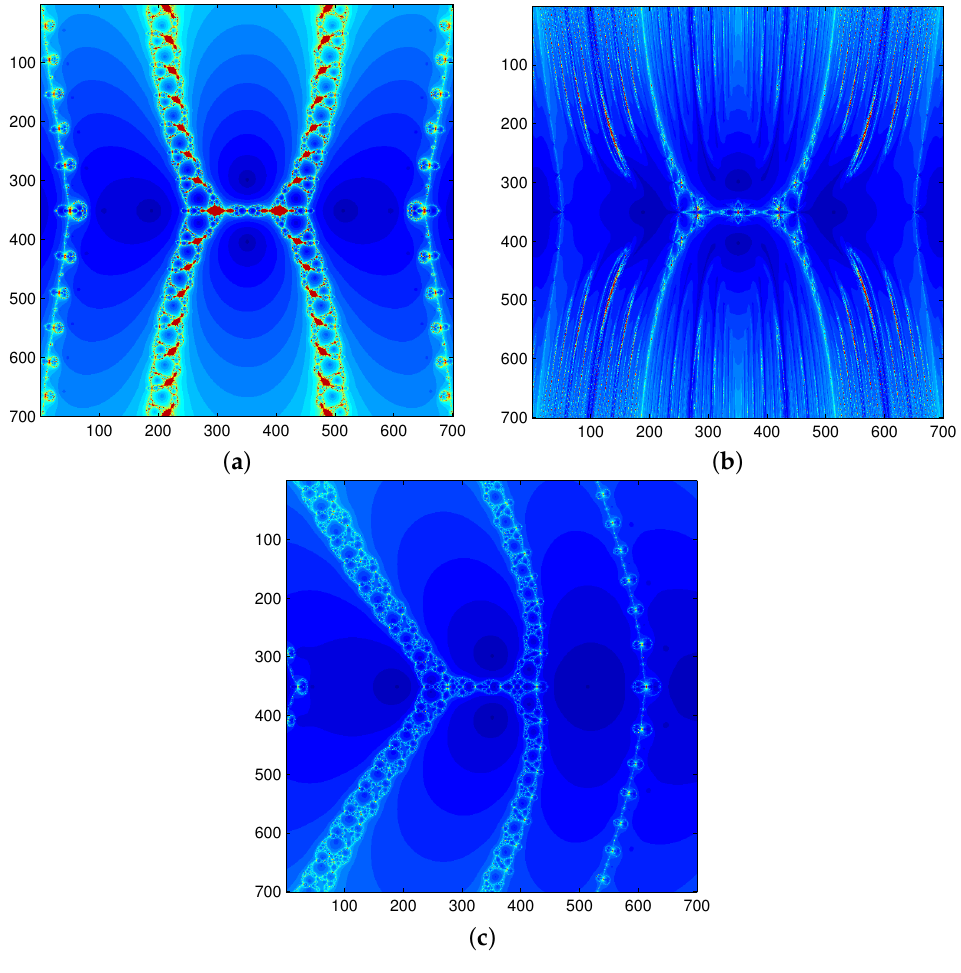
Figure 6. Dynamics of different methods for F 1 ( x ) = x sin x + cos x − 0.6: ( a ) Newton’s method; ( b ) Wang and Liu’s method; ( c ) proposed